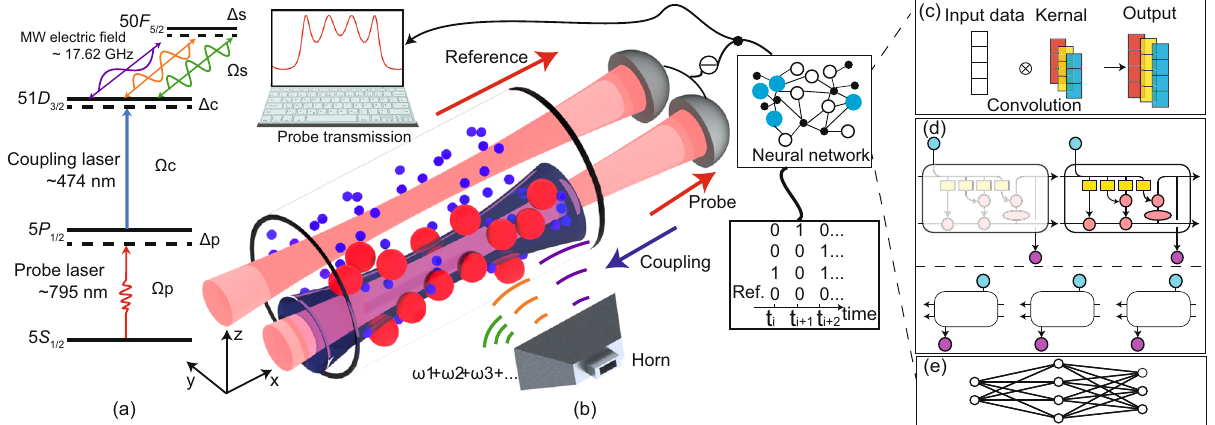
Fig. 1 Illustration of the setup. a Overview of experimental energy diagram. Probe and coupling laser beams excite the atoms at ground state j 5 S 1 = 2 i to the Rydberg state j 51 D 3 = 2 i . Multifrequency microwave (MW) electric fi elds couple the Rydberg states j 51 D 3 = 2 i and j 50 F 5 = 2 i . b Schematic of Rydberg atom- based antenna and mixer interacting with multifrequency signals. A 795 nm laser beam is split into two beams, which then propagate in parallel through a heated Rb cell (length: 10 cm, temperature: 44.6 ∘ C, atomic density: 9.0 × 10 10 cm − 3 ) 46 . One is the probe beam, which counterpropagates with the coupling laser beam exciting atoms to Rydberg states to reduce Doppler broadening. The other is the reference beam, which does not counterpropagate with the coupling laser beam. The beams are detected using a differencing photodetector (DD) to obtain the probe transmission spectrum (inset). Multifrequency MW fi elds transmitted by a horn are applied to the atoms, with a radiated direction that is perpendicular to the laser beam propagation direction. The multifrequency MW fi elds are modulated using a phase signal such that the phase differences between the reference bin and the other bins carry the messages. The probe transmission spectrum is fed into a well-trained neural network to retrieve the variations of the phases with time. c – e Schematics of the neural network. The network consists of c a one-dimensional convolution layer, d a bi-directional long – short-term memory layer and e a dense layer; for further details about these layers, see the “ Methods ”